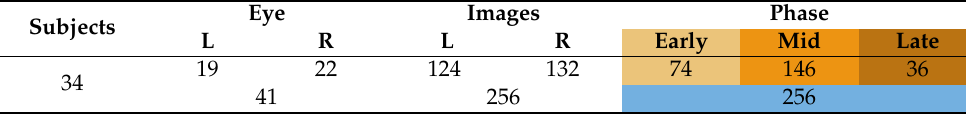
Table 1. Summary of the image test